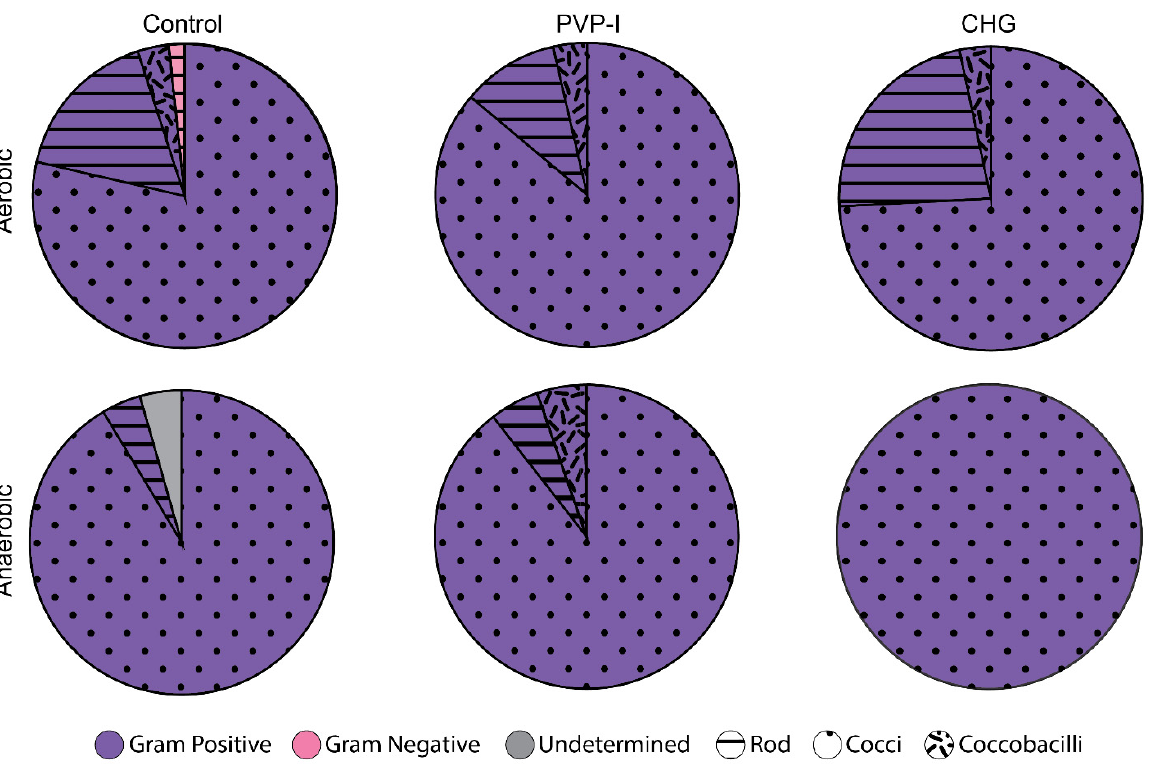
Figure 6. Distribution of every bacteria isolate from the three study groups characterized by Gram-stain analysis and morphology. Exactly 186 bacterial isolates were distributed as follows: 61 from the aerobic controls pooled from pigs 1–10, 24 from anaerobic controls pooled from pigs 1–10, 29 from the aerobic PVP-I from pigs 1–5, 19 from the anaerobic PVP-I from pigs 1–5, 31 from the aerobic CHG from pigs 6–10, and 22 from the anaerobic CHG from pigs 6–10. Gram-positive bacteria are shown with purple while Gram-negative bacteria are shown in pink. The shape (Rod, Cocci, or Coccobacilli) is indicated by the textures. The area of each pie chart represents the respective number of isolates identified in each